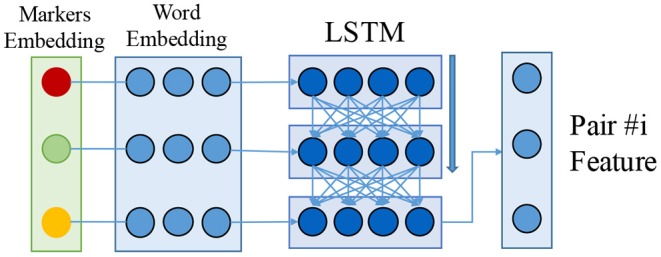
Encoder for textual entity pairs. We use the concatenation of marker embedding and word embedding with an LSTM model (Hochreiter and Schmidhuber, 1997; Greff et al., 2016) to encode the feature.